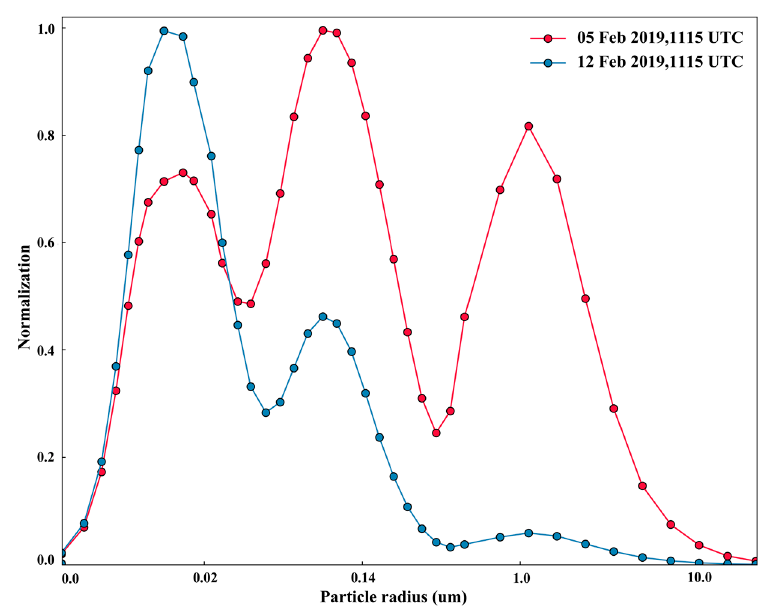
Figure 3. Normalized particle size distributions of Case I (5 Feb 2019, 1115 UTC, in red) and Case II (12 Feb 2019, 1115 UTC, in blue) from 0.002 μ m to 20 μ m obtained by combining aerodynamic particle sizer (APS), scanning mobility particle sizer (SMPS), and nano-scanning mobility particle sizer (Nano-SMPS) measurements.